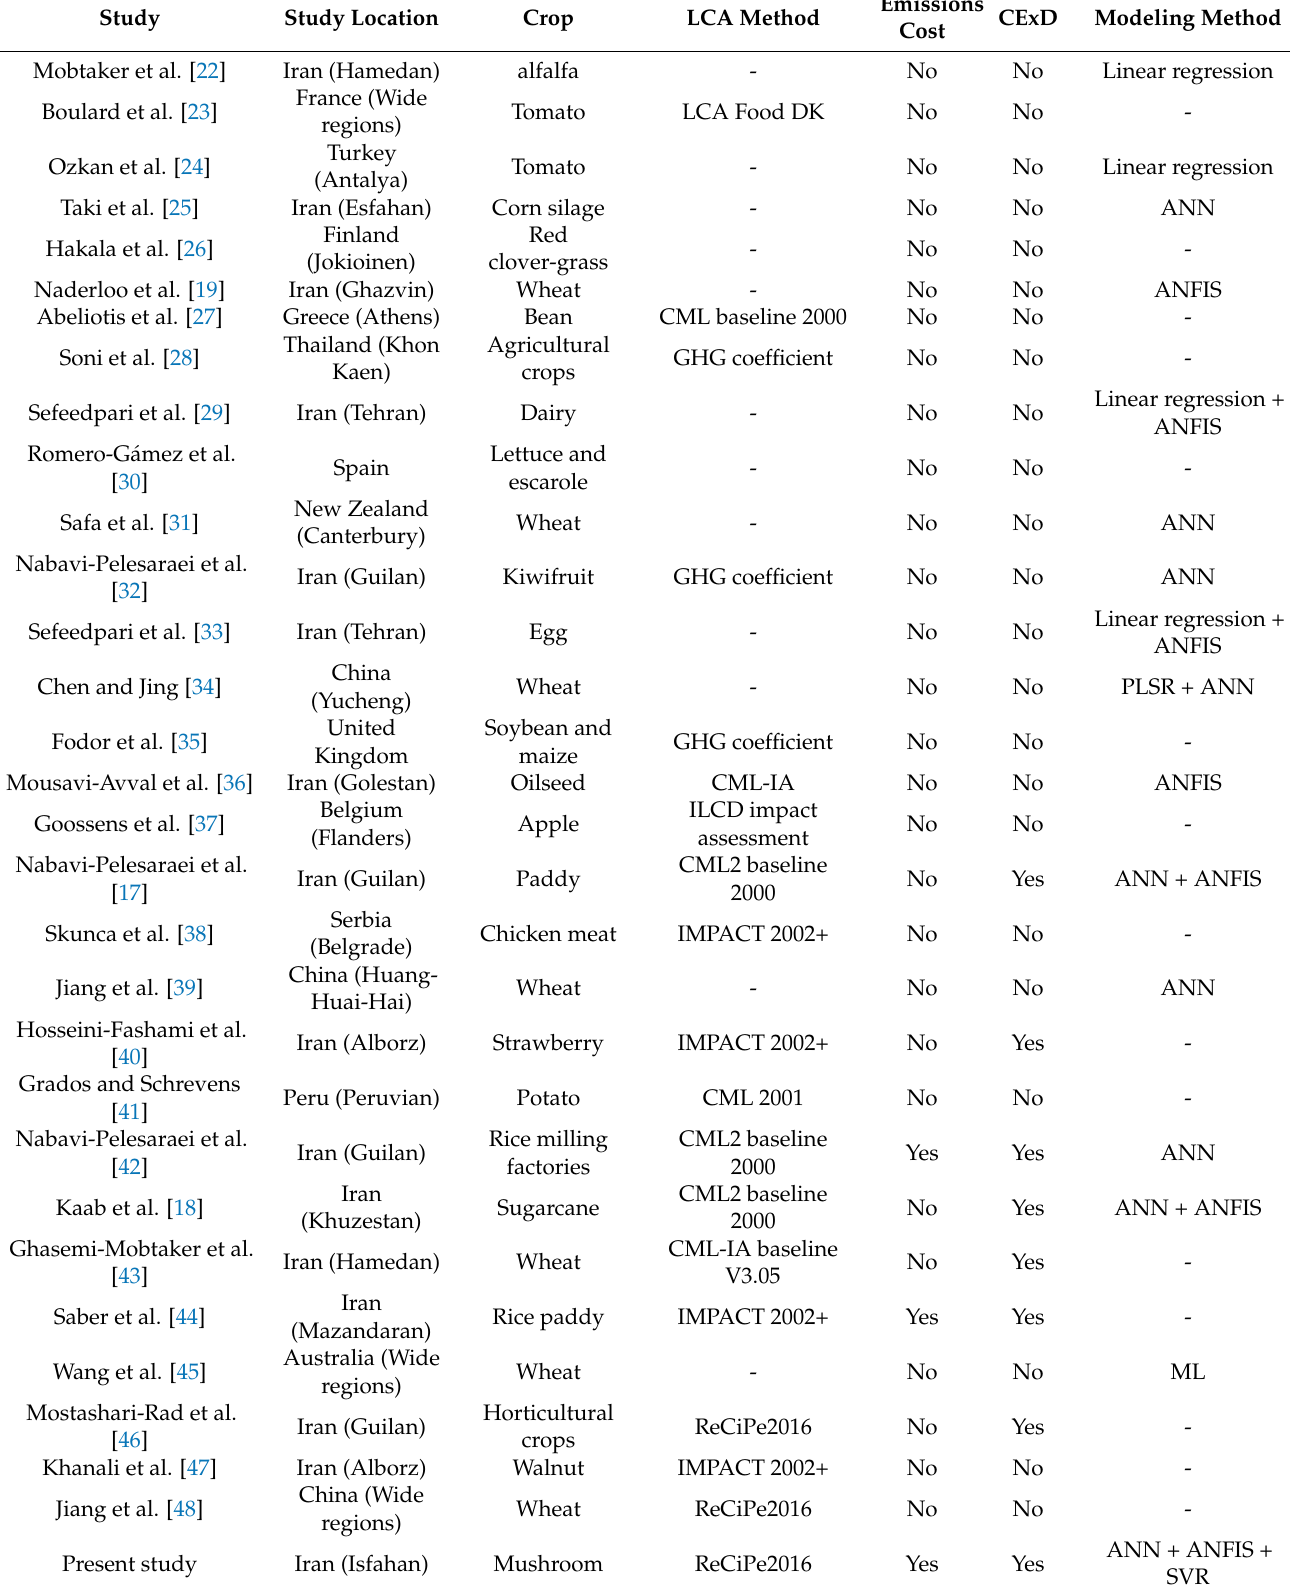
Table 1. Literature review on samples studies that have applied modeling, LCA, emissions cost, and CExD in agri-food